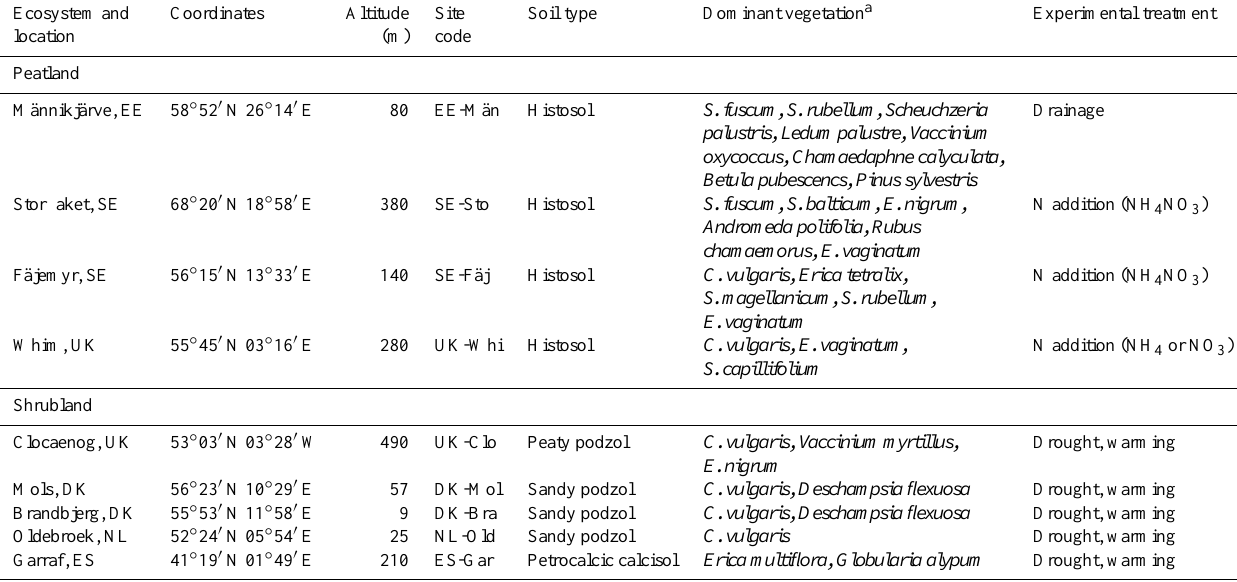
Table 1. Site characteristics.